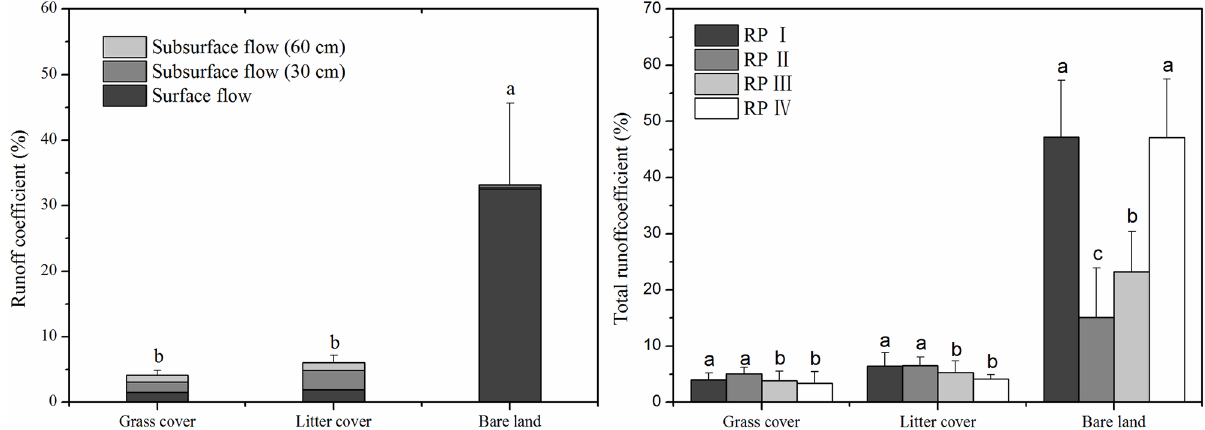
Fig 4. Total runoff values of the three land cover types under different rainfall